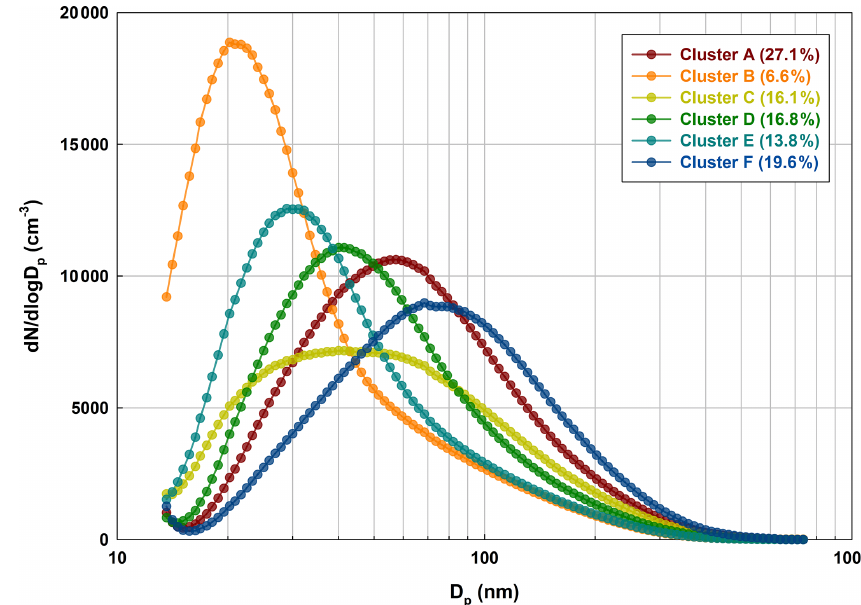
Figure 5. Mean particle number size distribution for each typical cluster obtained by the k -means clustering method. The occurrence fre- quencies of clusters A–F were calculated during 2012–2019.